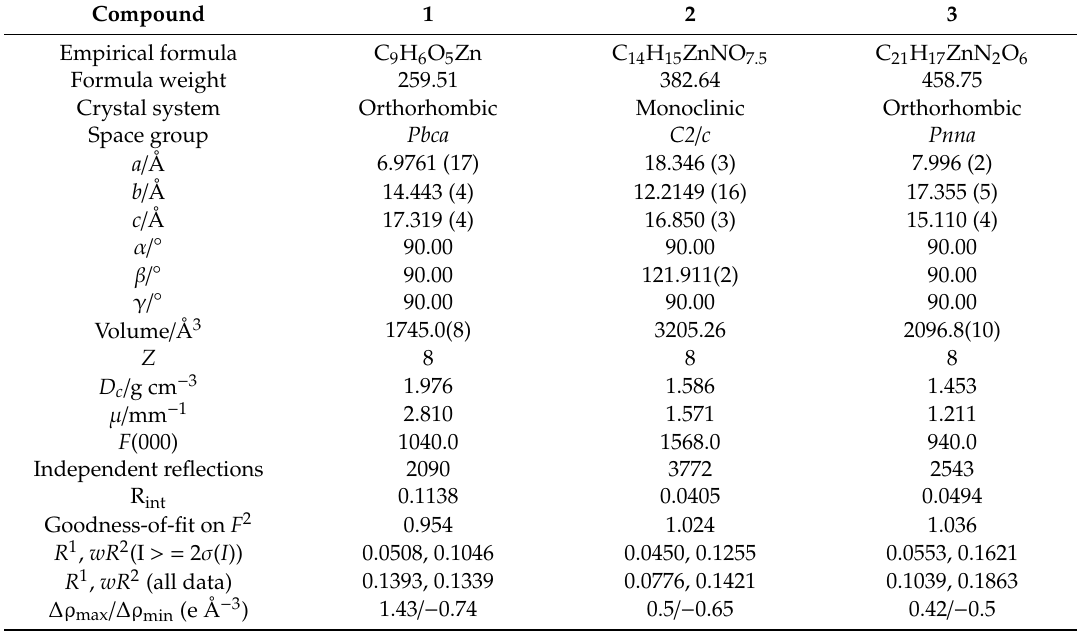
Table 1. Crystallographic data and structural parameters of compounds 1 – 3